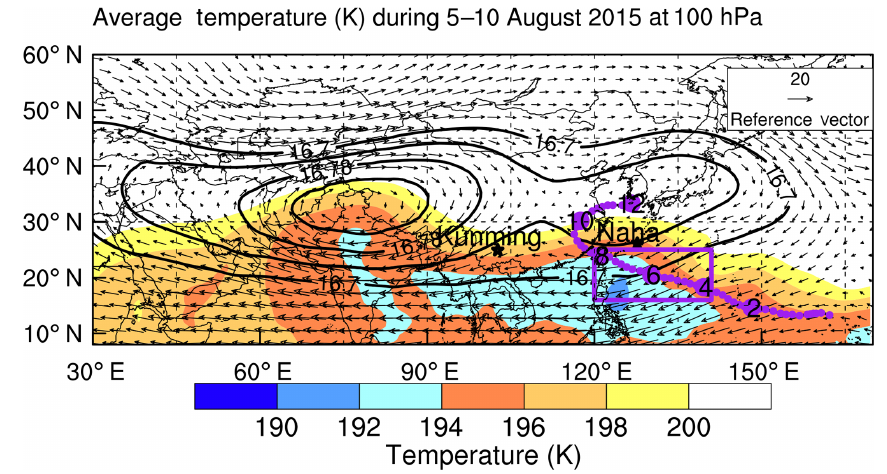
Figure 10. As Fig. 3 but for the case in August 2015 and Typhoon Soudelor.